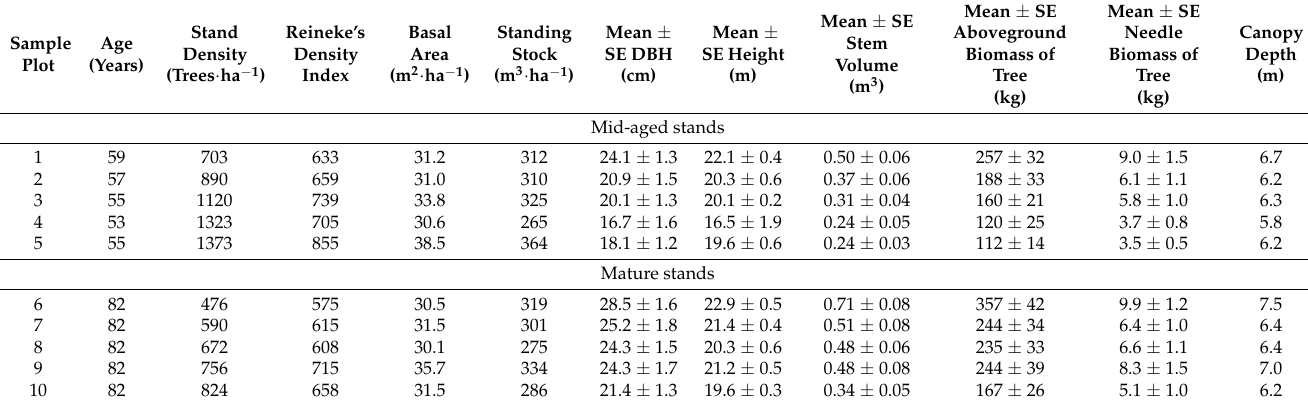
Table 1. Main characteristics of the sample plots established in mid-aged and mature Scots pine